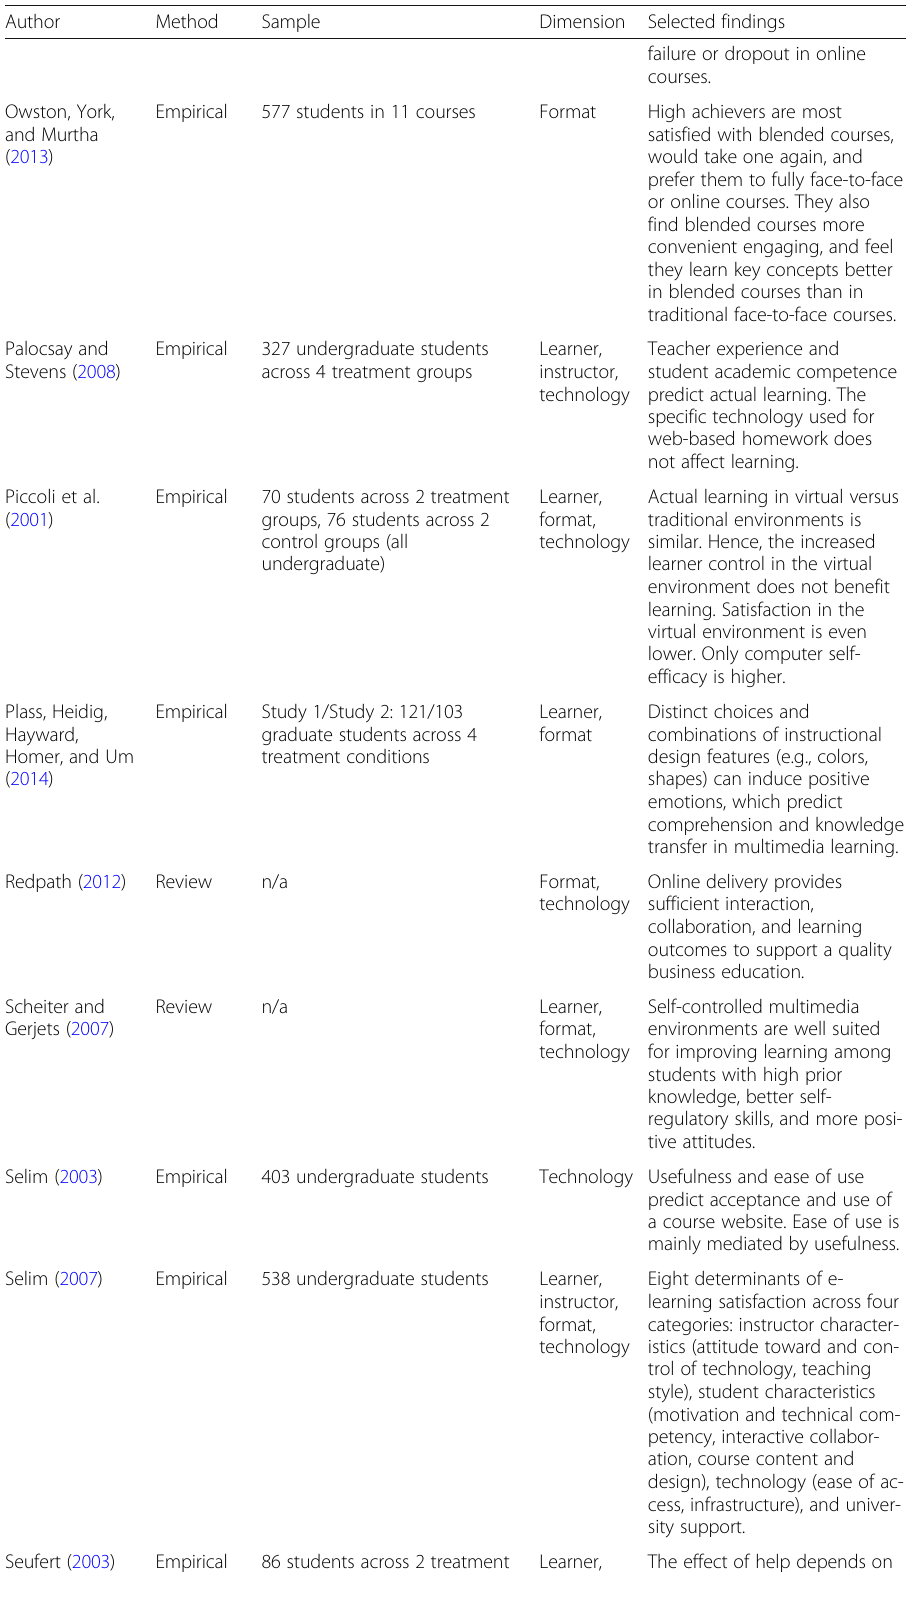
Table 1 Overview of Findings from the Extant Literature